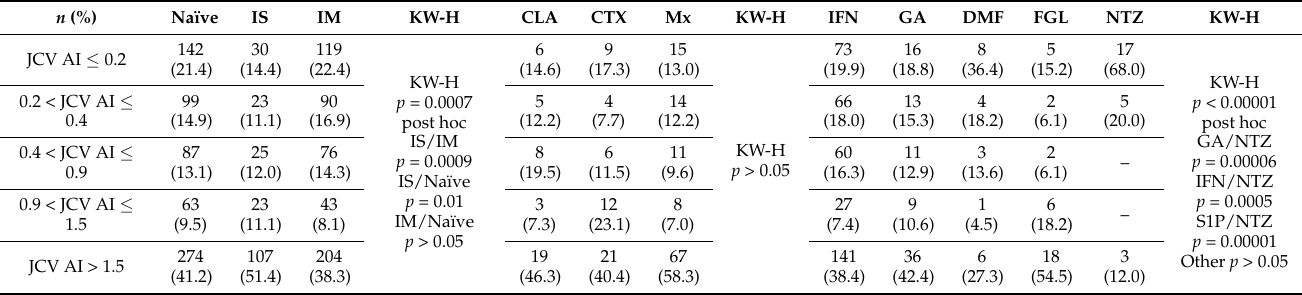
Table 7. Anti-JCV AI categories and patient’s